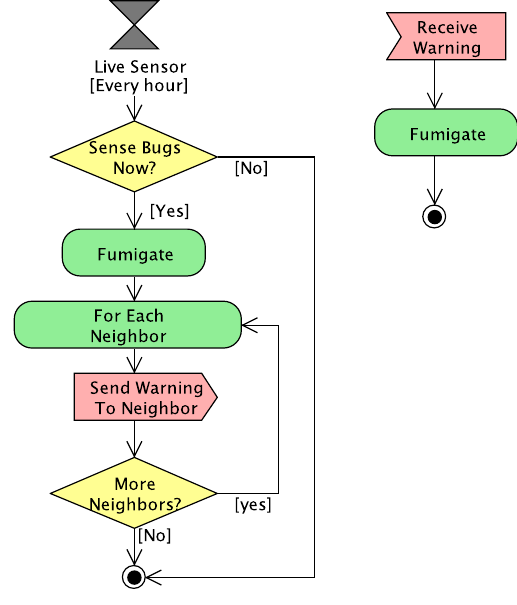
Figure 3. Functional block diagram of the smart neighbor